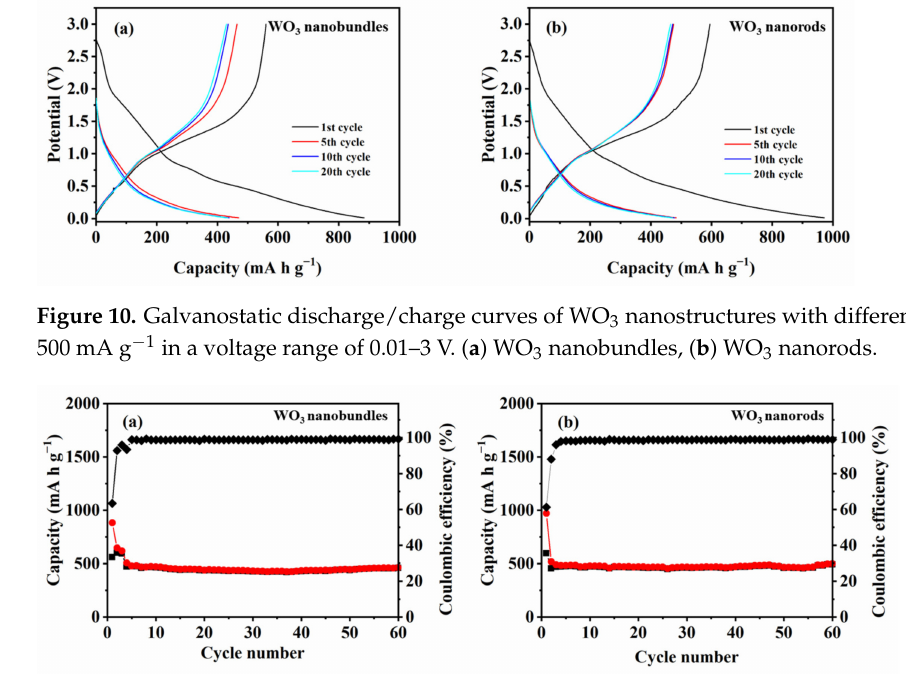
Figure 11. Cycle performances of WO 3 nanostructures with different shapes at 500 mA g − 1 in a voltage range of 0.01–3 V. ( a ) WO 3 nanobundles, ( b ) WO 3